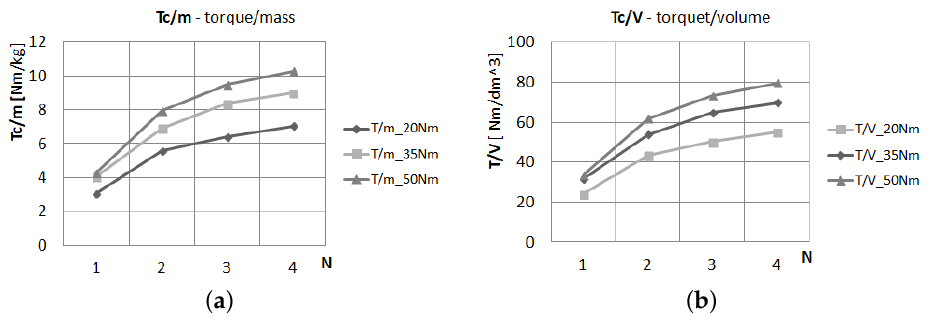
Figure 13. T c / m ratio vs. number of discs N ( a ) and T c / V ratio vs. number of discs N ( b ) for MR clutches T c = 20,35,50